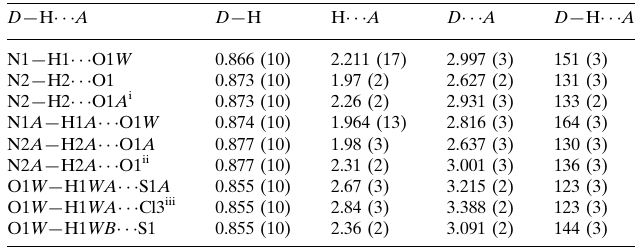
Hydrogen-bond geometry (A˚ , (cid:2)